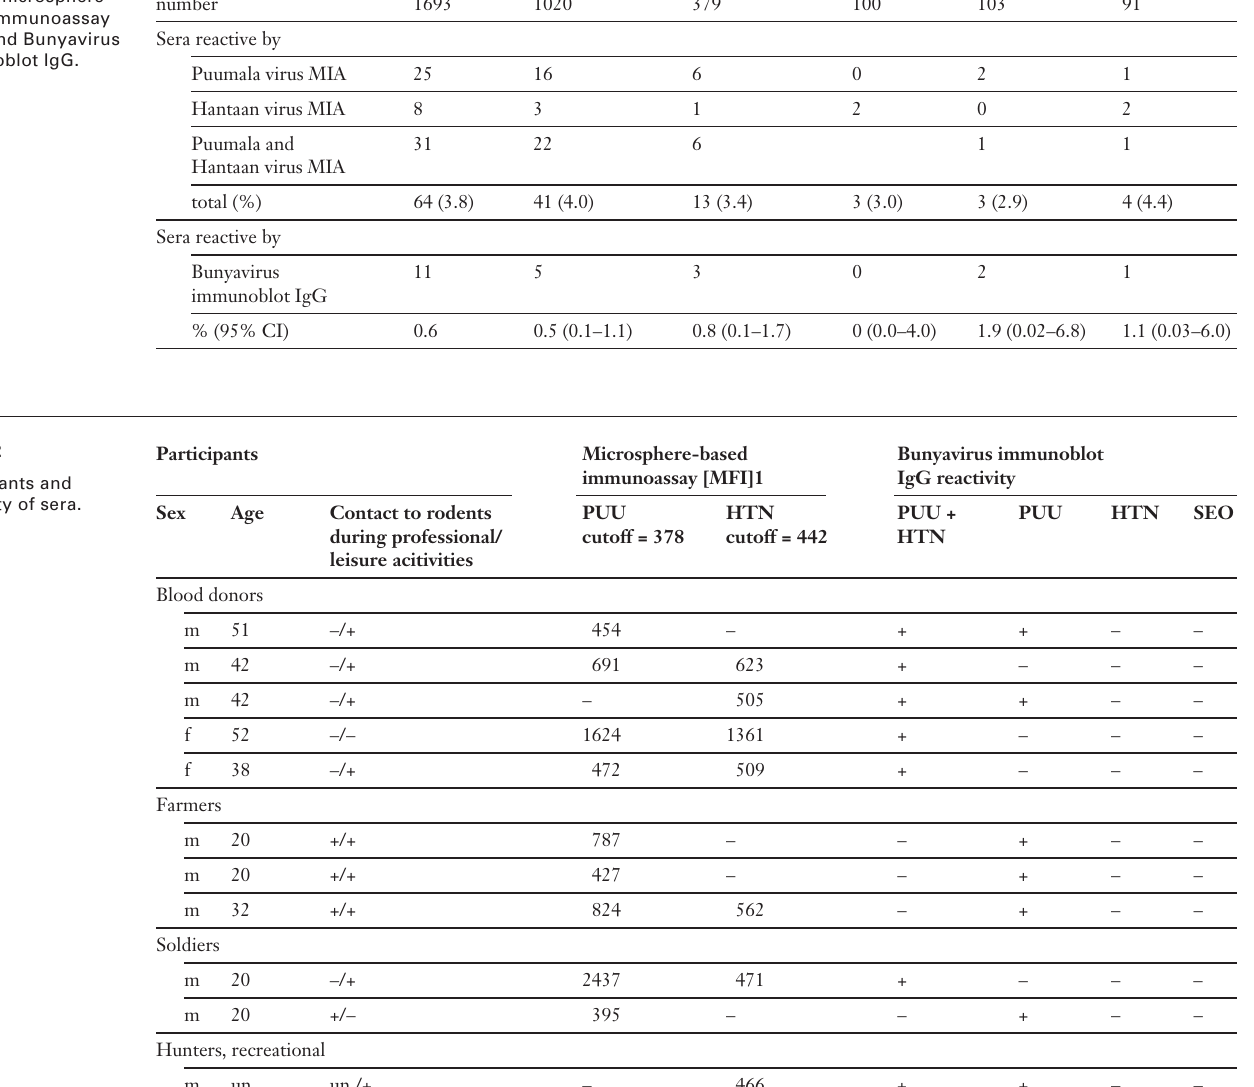
Number of sera reac- tive by microsphere- based immunoassay (MIA) and Bunyavirus immunoblot IgG.